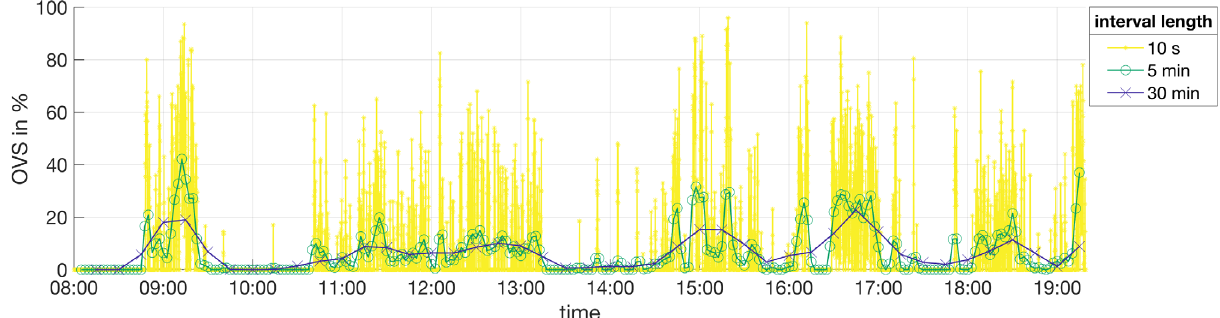
Figure 1. Percentage of manually labeled OVS for different analysis interval lengths during the real-world recordings of one subject.